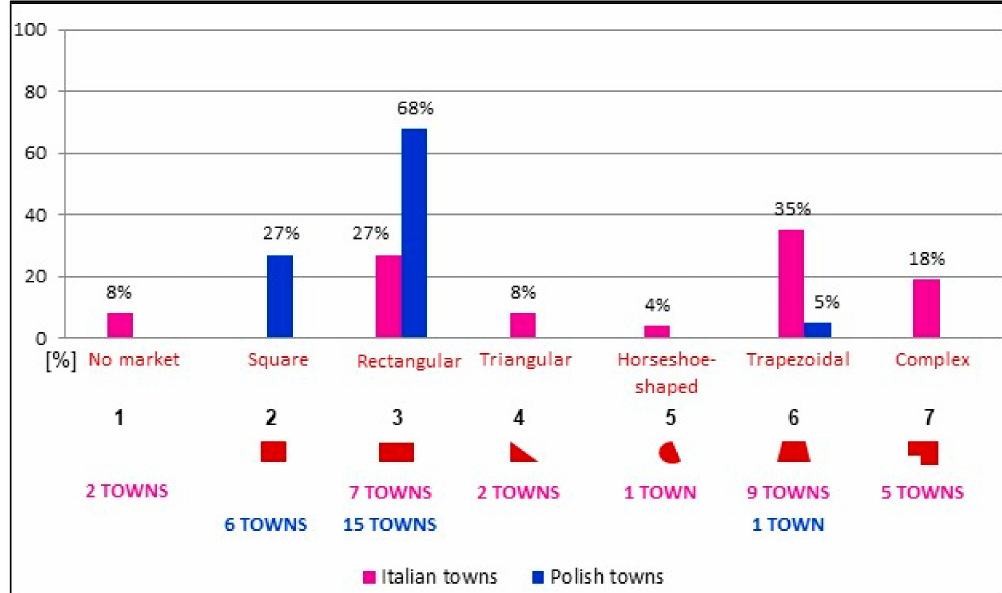
Figure 6. Shape of market squares in Italian and Polish towns. Source: own elaboration. Key: 1—Italian 2 towns: Bucine (T), San Vicenzo (T); 2—Polish 6 towns: Działdowo, Gołdap, Lidzbark Warmi´nski, Lubawa, Nowe Miasto Lubawskie, Reszel; 3—Italian 7 towns: Capalbio (T), Marradi (T), Suvereto (T), Monte Castello di Vibio (U), Orvieto (U), Todi (U), Torgiano (U); Polish 15 towns: Barczewo, Bartoszyce, Biskupiec, Bisztynek, Braniewo, Dobre Miasto, G ó rowo Iławeckie, Jeziorany, Lidzbark, Olsztynek, Orneta, Nidzica, Pasym, Ryn, Wydminy; 4—Italian 2 towns: Castelnuovo Berardenga (T), Greve in Chianti (T); 5—Italian 1 town: Montefalco (U); 6—Italian 9 towns: Barga (T), Civitella in val di Chiana (T), Cortona (T), San Miniato (T), Citta della Pieve (U), Preci (U), Ficulle (U), Parrano (U), Trevi (U); Polish 1 town: S˛epopol; 7—Italian 5 towns: Abetone Cutigliano (T), Anghiari (T), Massa Marittima (T), Pratovecchio (T), Amelia (U). Table 10. Tuscan towns—developed area. Developed Area within Contemporary No. Town City Walls [ha] Built-Up Area